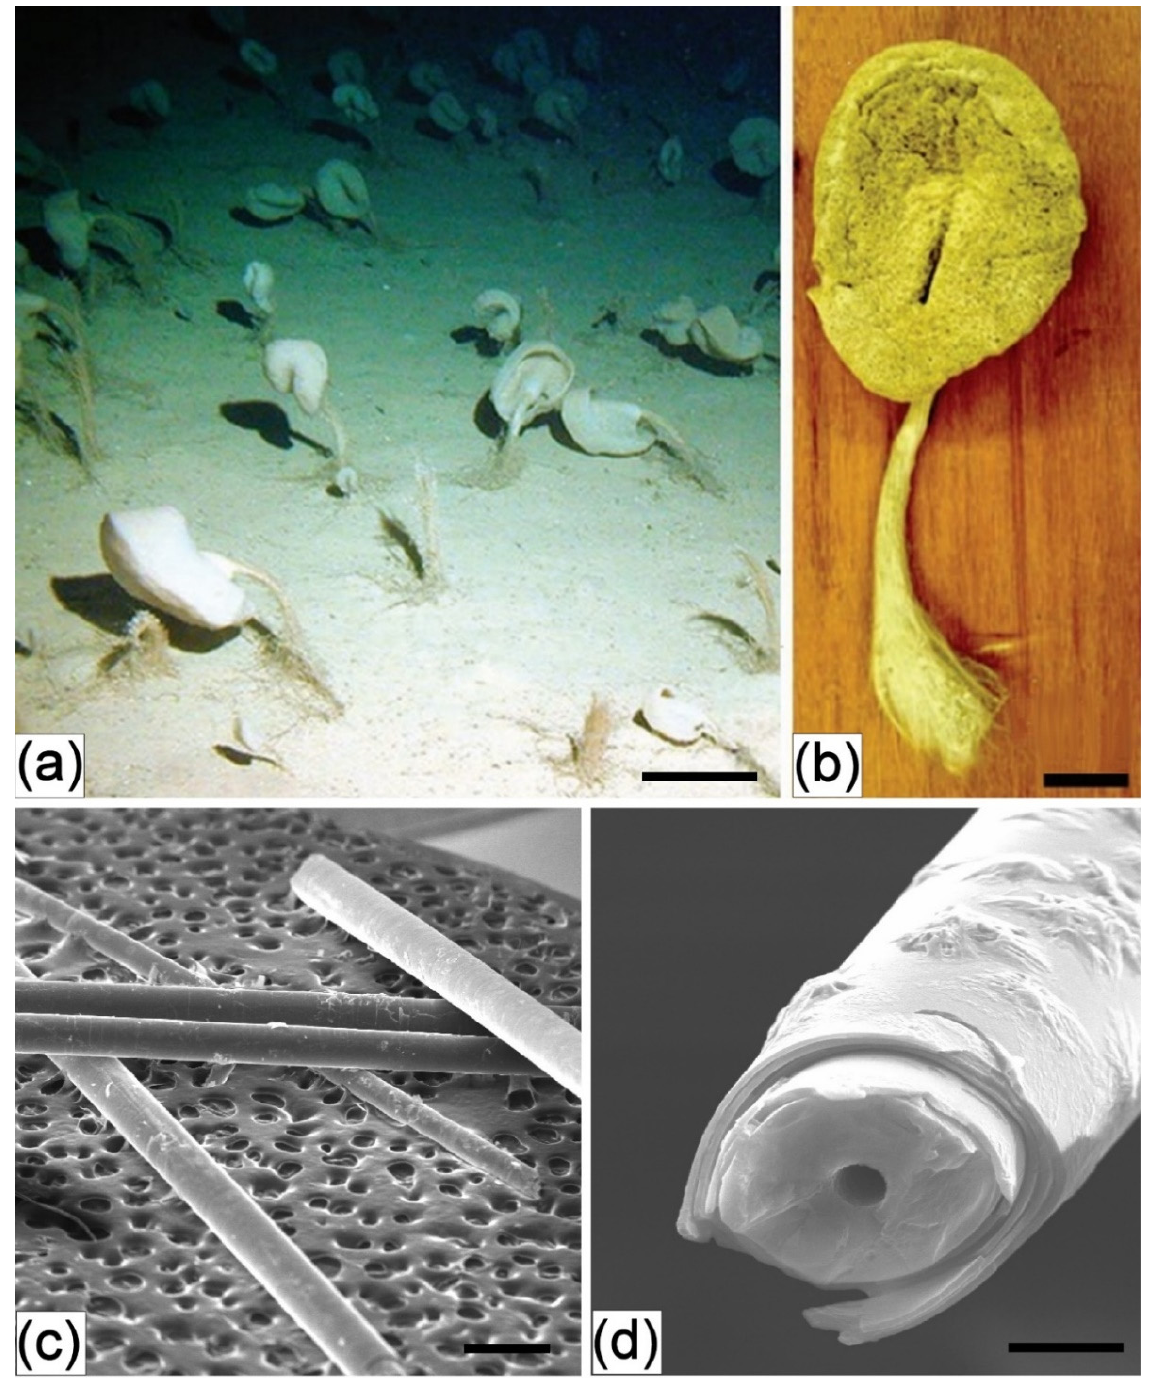
Figure 3. Sericolophus sp. Morphological feature ( a , b ) and the ultrastructure of the spicules by SEM ( c , d ). Scale: ( a )—10 cm, ( b )—5 cm, ( c )—600 μ , ( d )—10 μ .